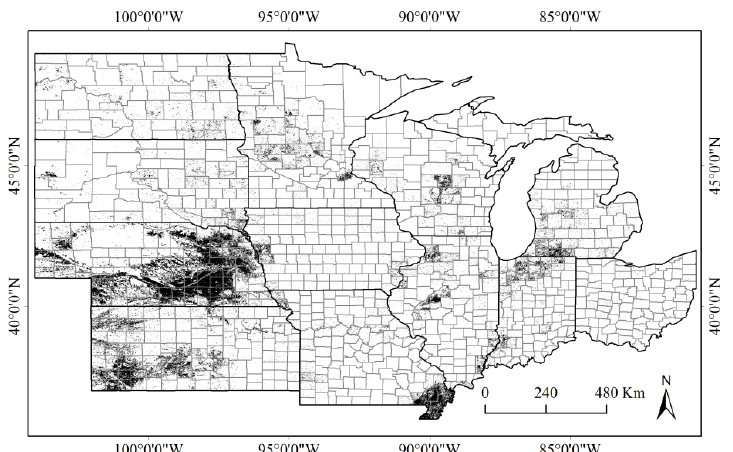
Figure 3. The map of irrigated areas from the early warning program of USGS in